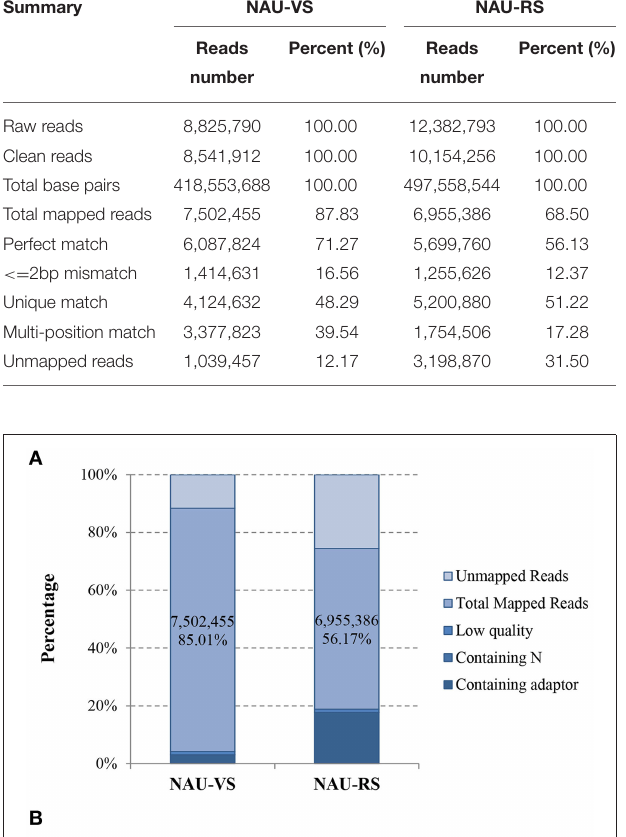
including 779 up-regulated and 5143 down-regulated genes were obtained from NAU-VS and NAU-RS libraries ( Table S1 ; Figure 1B